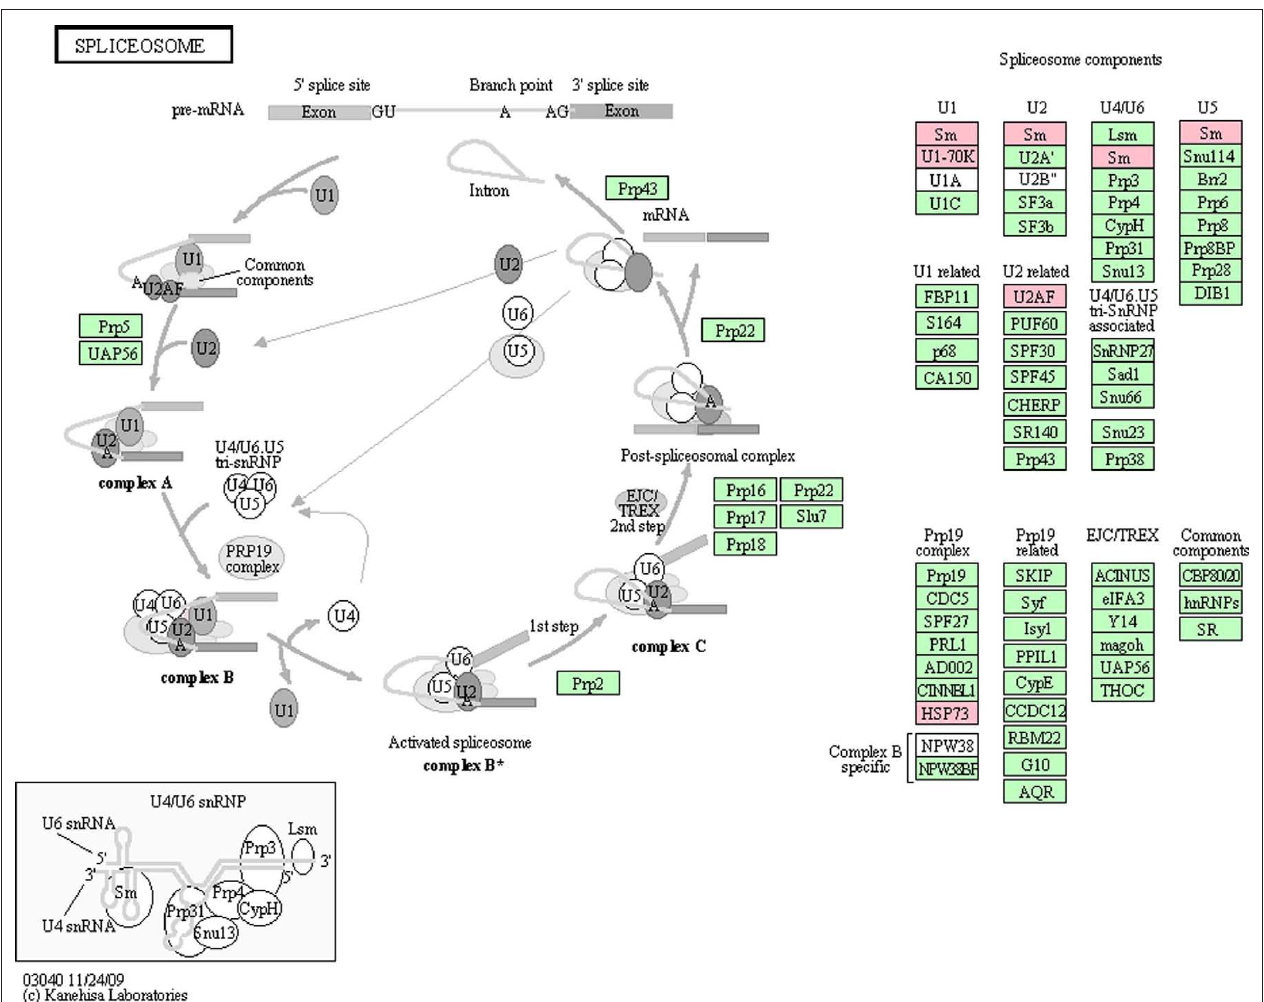
snRNP69D (small nuclear ribonucleoprotein at 69D), and snRNP70K (small nuclear ribonucleoprotein 70K). Green boxes represent other members in the pathway database for Drosophila melanogaster